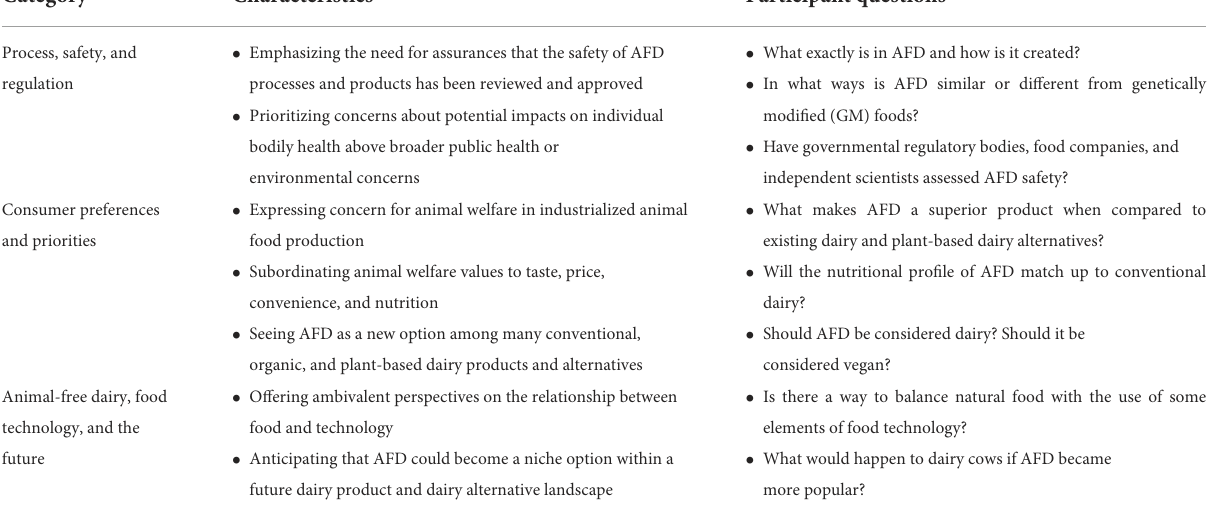
TABLE 1 Thematic categories, characteristics, and key participant questions.